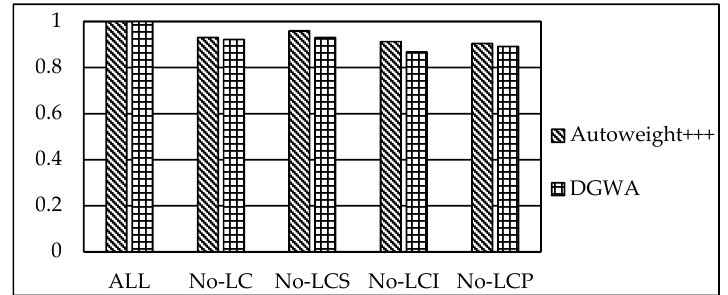
Figure 11. Comparison of methods Autoweight+++ and DGWA according to the results of precision measure for different groups of test cases within Benchmark biblio ontology track.